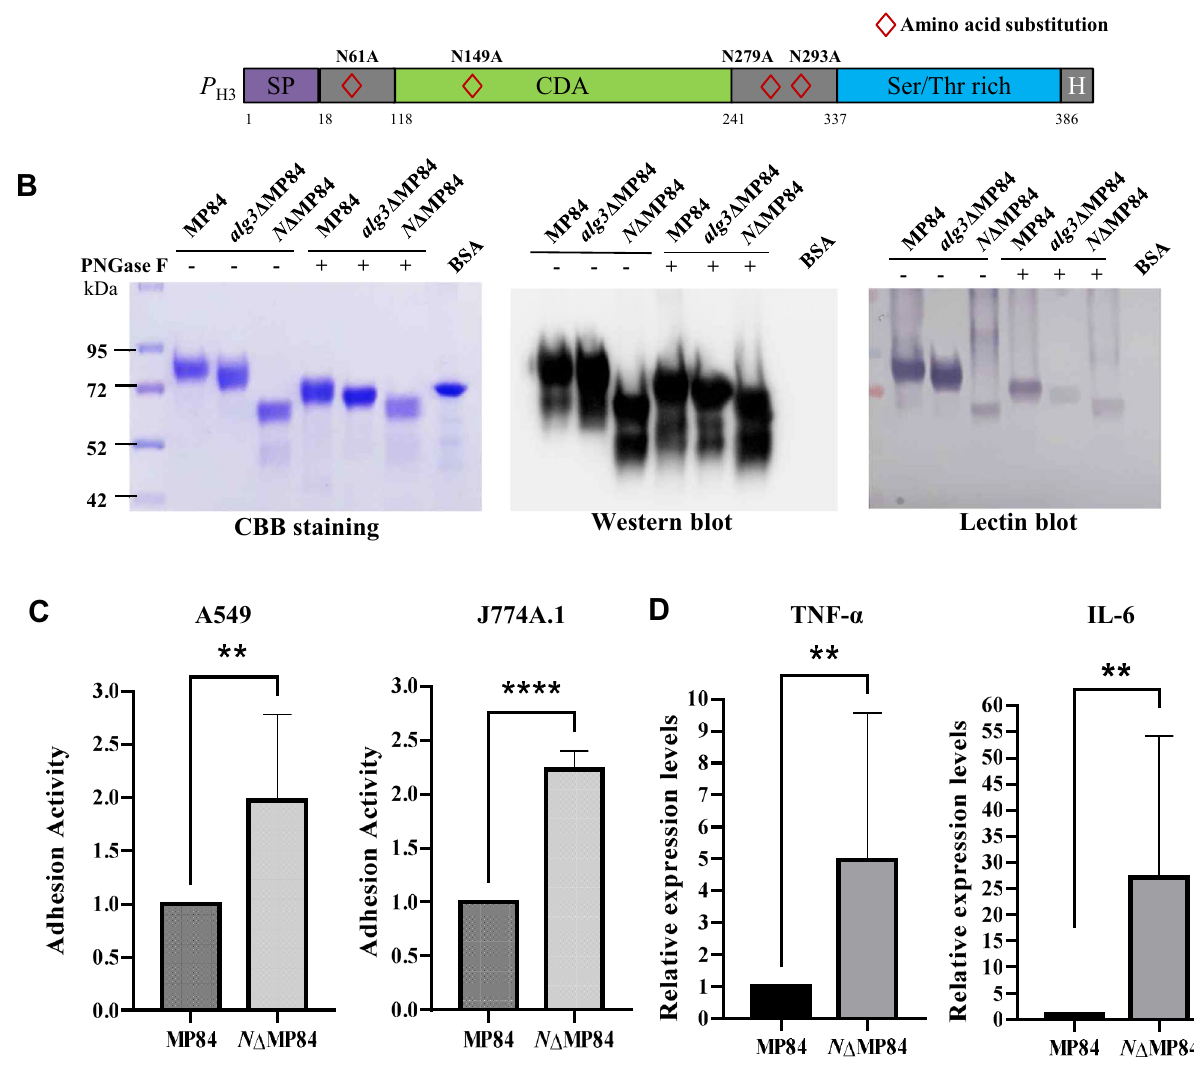
Figure 5. Effect of the absence of N -glycans on the interaction of MP84 with host cells. ( A ) Scheme of the engineered MP84 protein lacking all four predicted N -glycosylation sites ( N ΔMP84). All asparagine (Asn) residues in N -glycosylation sites were exchanged with alanine (Ala) residues. ( B ) Expression analysis of MP84 lacking N -glycosylation sites ( N ΔMP84). The MP84 secreted by the WT and alg3 Δ strains, and the MP84 lacking N- glycosylation sites were separated via SDS-PAGE and subjected to Coomassie staining, Western blot analysis using anti-His antibody, and lectin-blotting (GNA-AP). The raw data of SDS-PAGE, western blot analysis, and lectin-blotting in ( B ) were presented in Supplementary Information as Fig. S6. (C) Comparison of adhesion activities in host cells between MP84 and N ΔMP84. Significant differences were obtained via one-way ANOVA (** P ≤ 0.01, **** P ≤ 0.0001). ( D ) Comparison of the secreted cytokines between BMDCs co-incubated with MP84 and N ΔMP84. Significant differences were obtained via one-way ANOVA (** P ≤